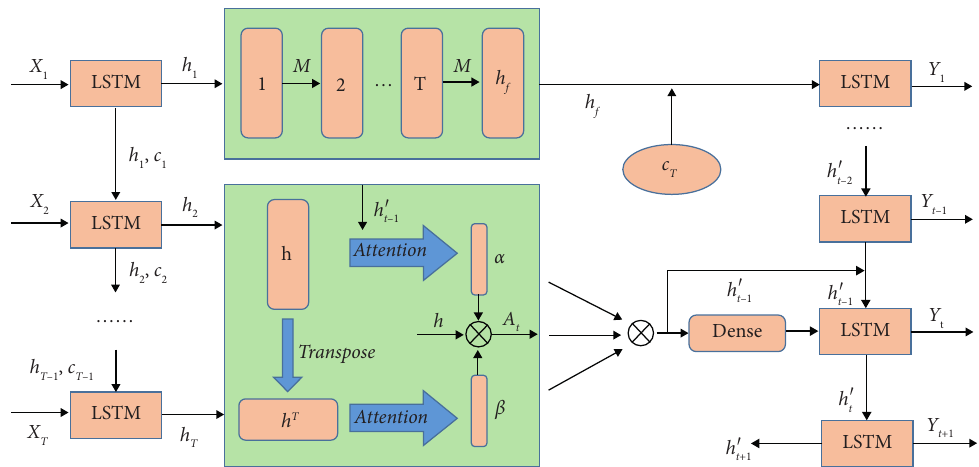
Figure 3: Structure diagram of multitime series attention network